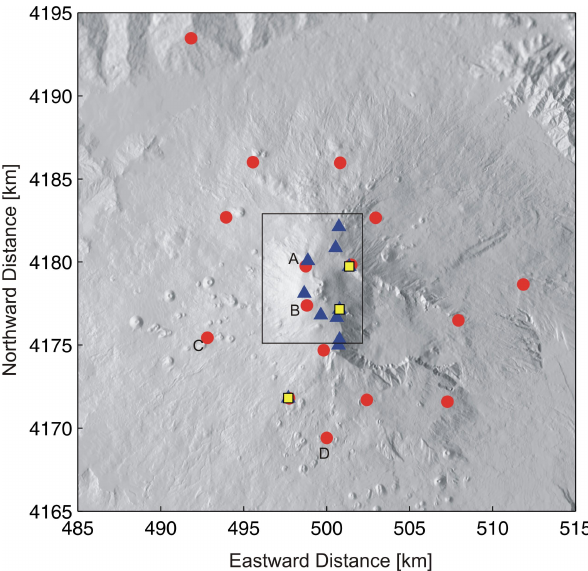
Fig. 2. Permanent GPS (red circles), gravity (yellow squares) and magnetic (blue triangles) stations of the monitoring networks on Mt Etna. The black rectangle corresponds to the projection on sur- face of the volume where the sources are located.